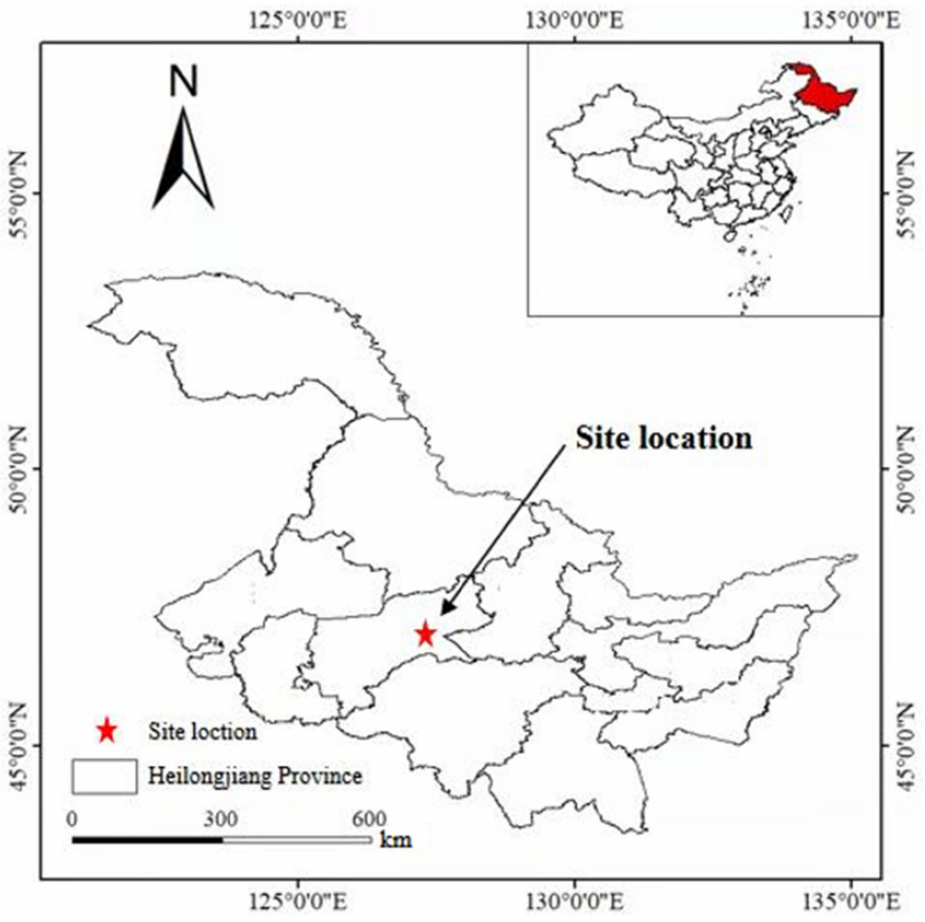
Figure 1. Experimental site